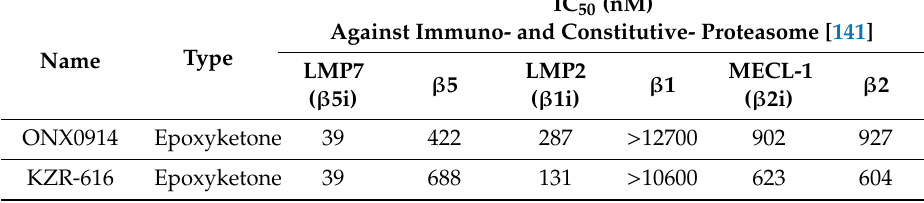
Table 2. Immunoproteasome